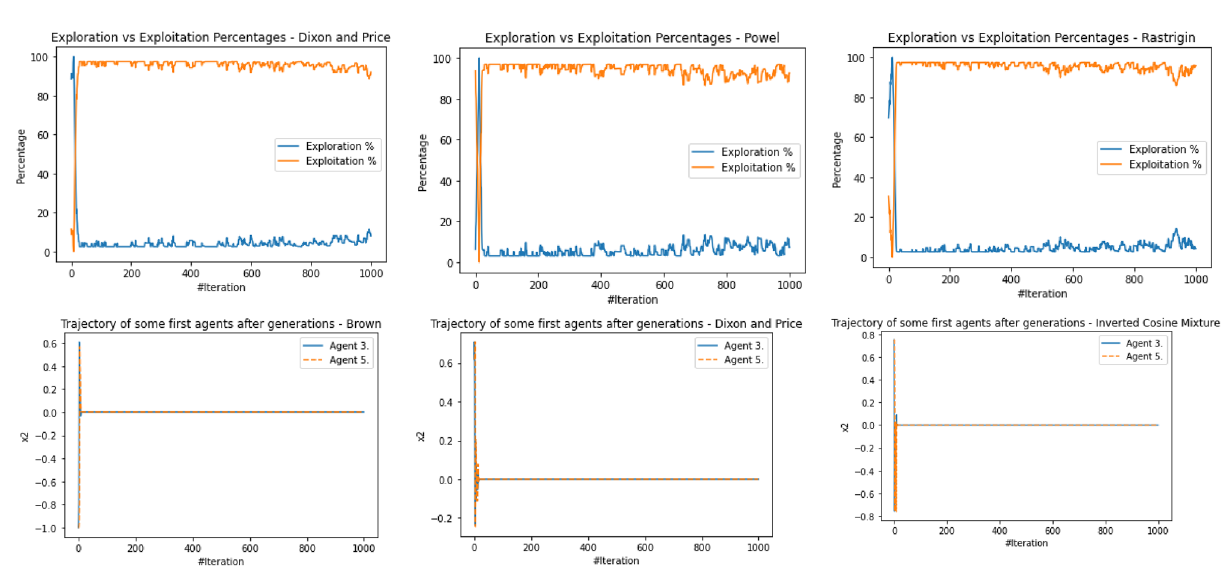
Figure 9. A graphical illustration of the convergence of IEOSA based on the trajectory of some selected solutions for Brown, Dixon and Price and Inverted Cosine Mixture functions, and the overall exploration and exploitation of Dixon and Price, Powel, and Rastrigen